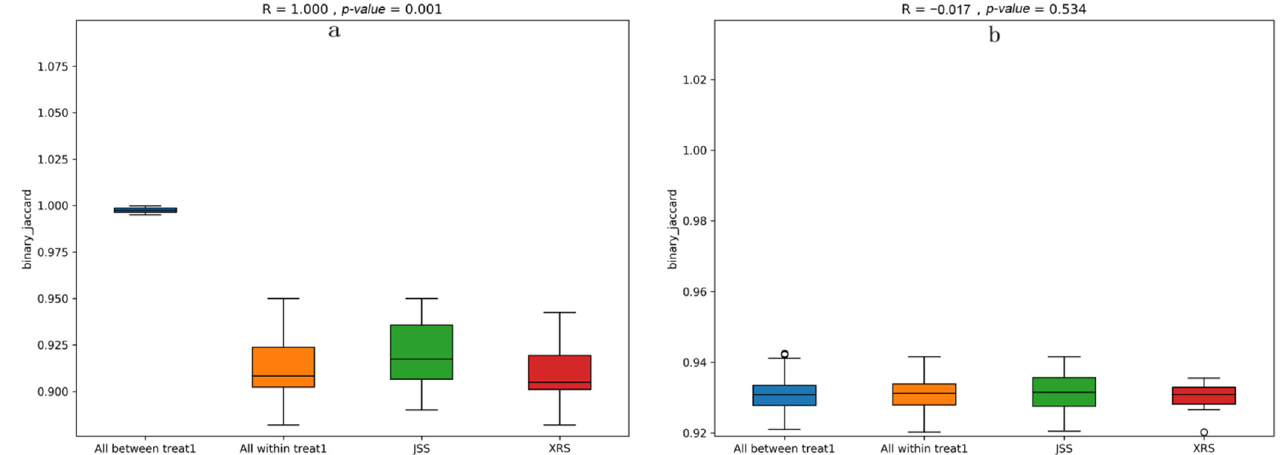
Figure 5. PERMANOVA analysis between different groups. ( a ) The permanova analysis of bacteria; ( b ) the permanova analysis of fungi. JSS: the bulk soil sample; XRS: soil of the P. sibiricum rhizosphere.